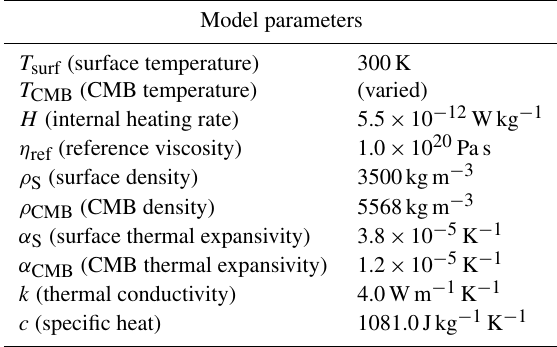
Table 1. Physical parameters common to all model runs. See Table 2 for the parameters varied between models.